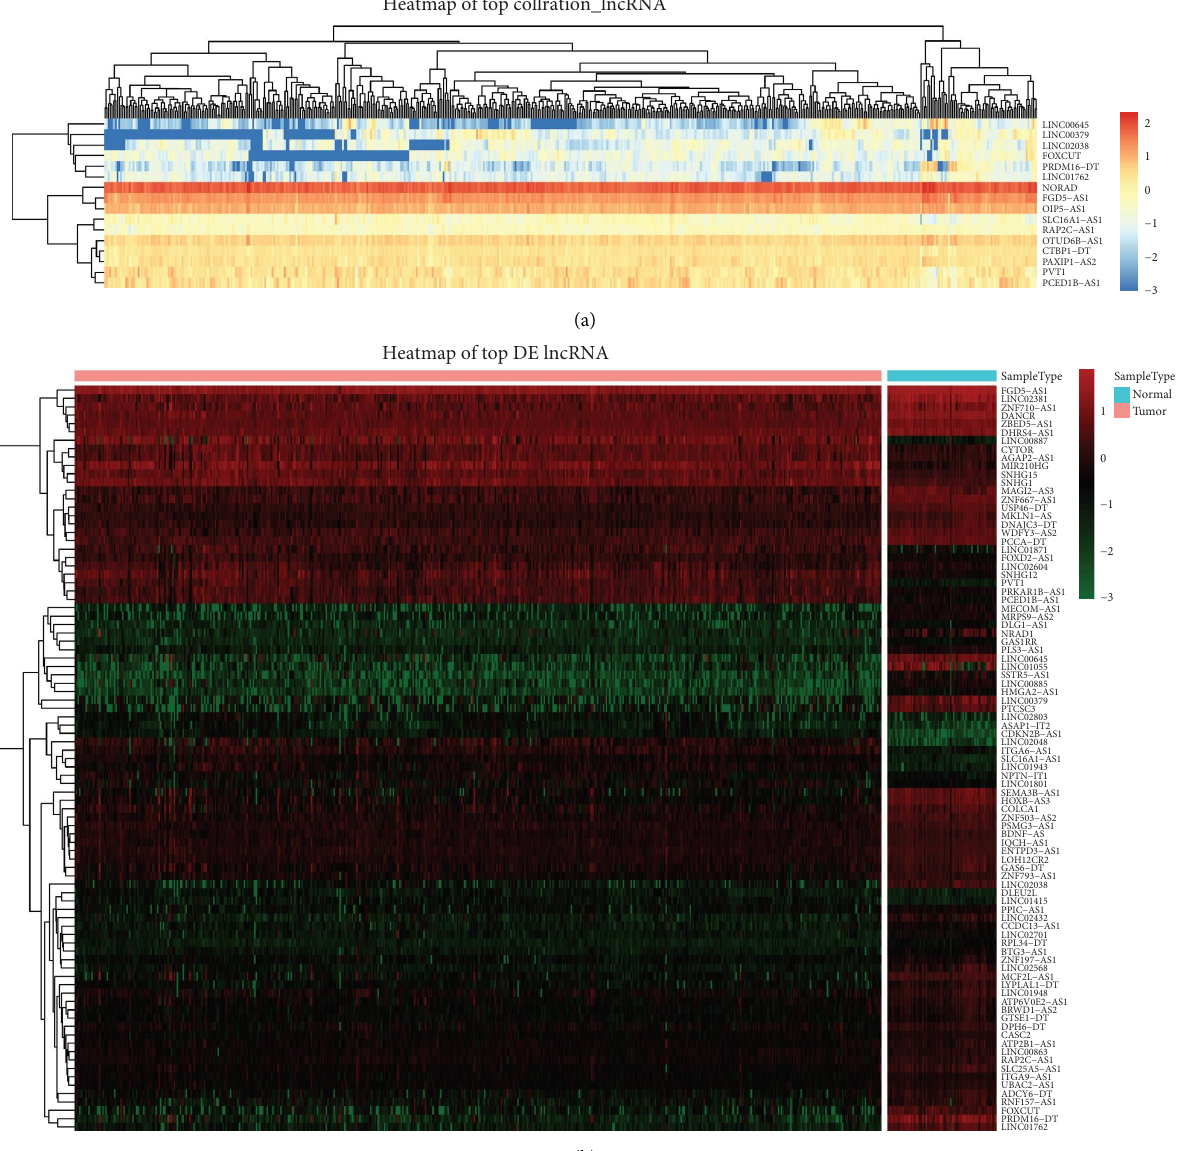
Figure 1: Select cuprotosis-related lncRNAs and identify diferentially expressed cuprotosis-related lncRNAs in KIRC. (a) Heat map of top cuprotosis-related lncRNAs associated with KIRC. (b) Heat map presenting the diferential expression of the cuprotosis-related lncRNAs associated with